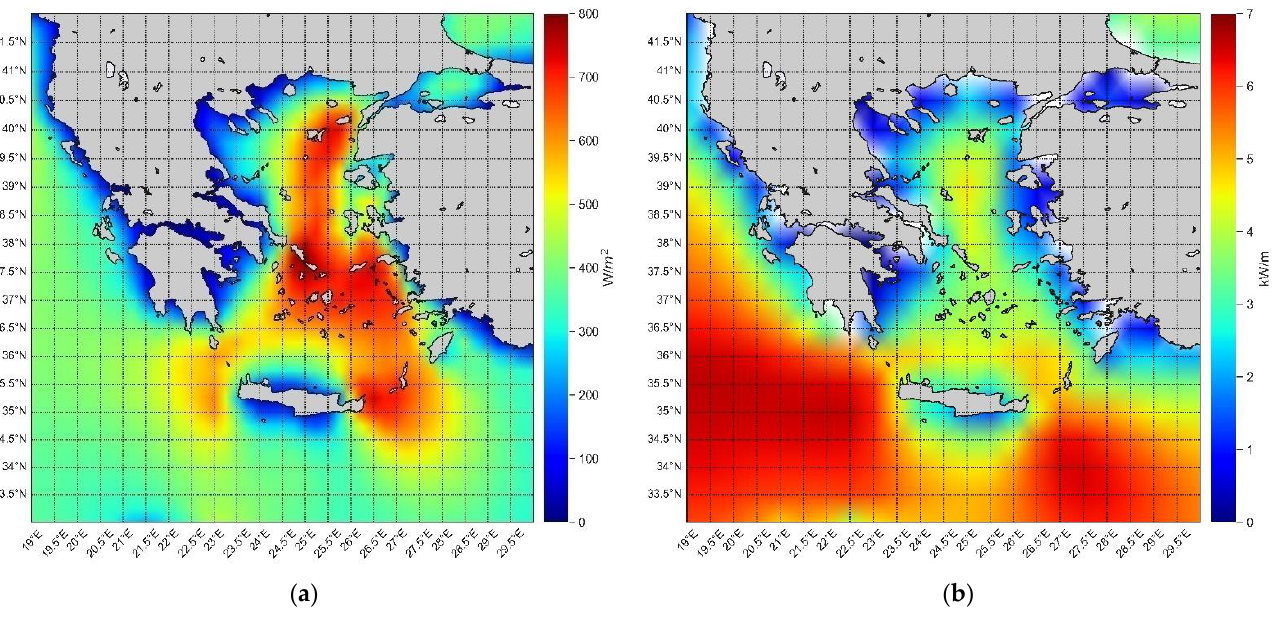
Figure 5. Offshore wind ( a ) and wave energy ( b ) potential.